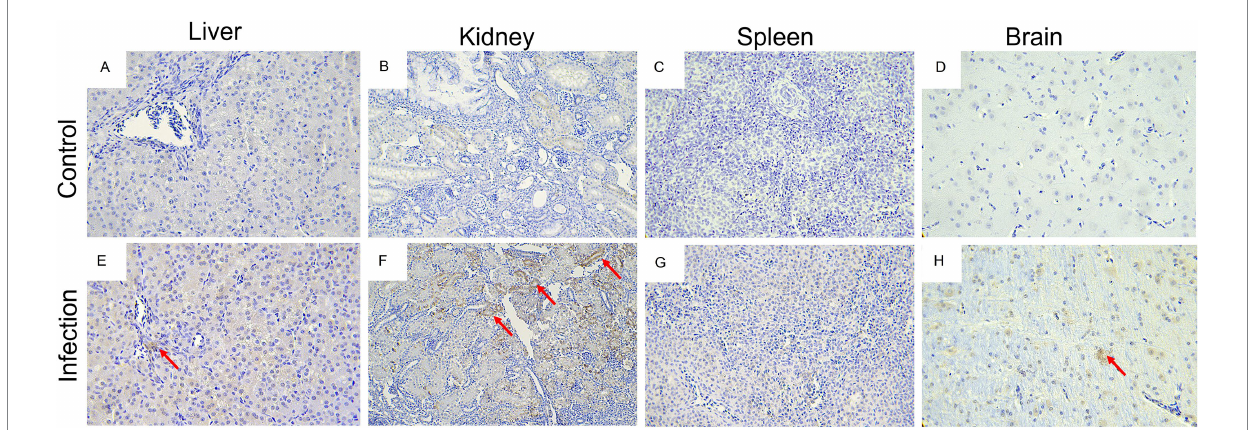
FIGURE 9 Immunohistochemistry analysis of GoAstV infected tissues. Tissue sections were deparaffinating, hydrated, water-bath heated for antigen retrieval, blocked with the addition of 3% hydrogen peroxide for immunohistochemistry, probed with indicated antibodies, and stained with indicated reagent. No positive signals were observed in the liver (A) , kidneys (B) , spleen (C) , and brain (D) of goslings in the control group. Positive signals were observed in the liver (E) , kidneys (F) , spleen (G) , and brain (H) of goslings in the challenge